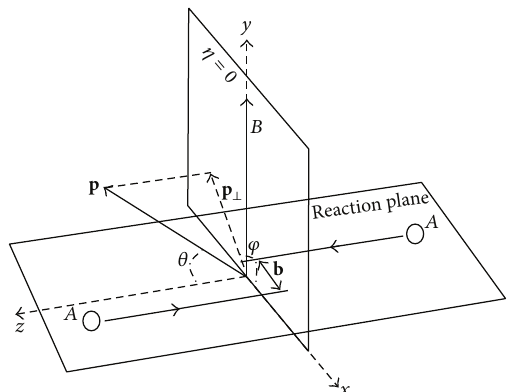
Figure 7: Geometry of a heavy-ion collision. p denotes momentum of a fast quark. Two orthogonal planes are the reaction plane span by the initial heavy-ion momenta and the mid rapidity plane 𝜃 = 𝜋/2 , which is labeled as 𝜂 = 0